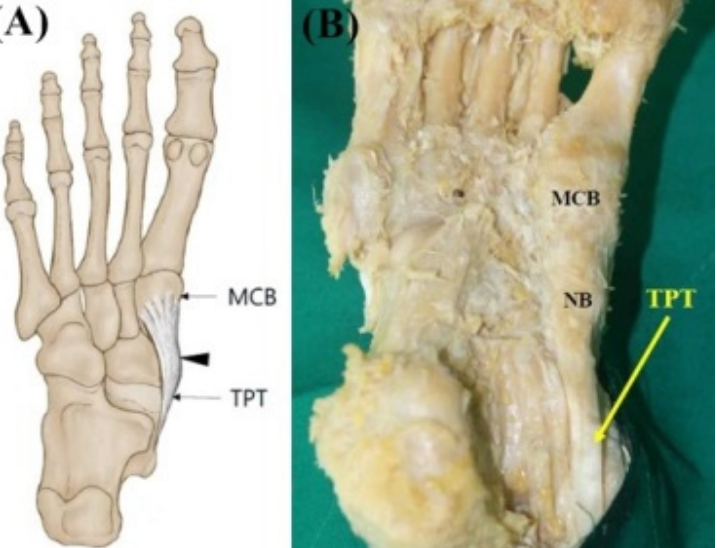
Figure 1. ( A ) Schematic drawing of the Type 1 tibialis posterior tendon insertion. Black-colored arrow indicates TPT inserts to the navicular bone. ( B ) Photo of the Type 1 tibialis posterior tendon insertion. The main tendon inserts to the navicular bone and the medial cuneiform bone (yellow-colored arrow). TPT, tibialis posterior tendon; NB, navicular bone; MCB, medial cuneiform bone. Type 2 (double insertions) consists of two tendons. The main tendon inserts, as in Type 1, and an accessory tendon inserts into the lateral cuneiform bone. This type was found in 13 feet (11.0%) (Figure 2).